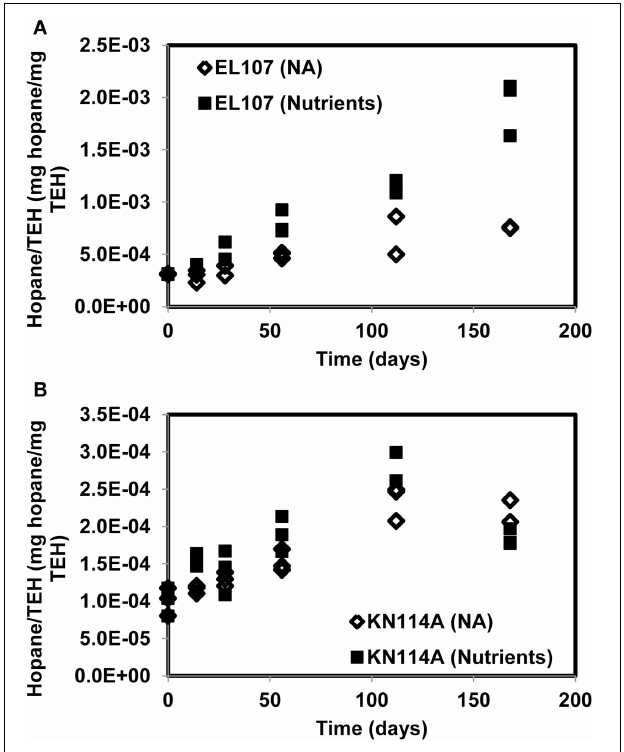
TEH (total extractable hydrocarbon) for (A) the EL107 and (B) the KN114A microcosms. The overall increase with time reflects